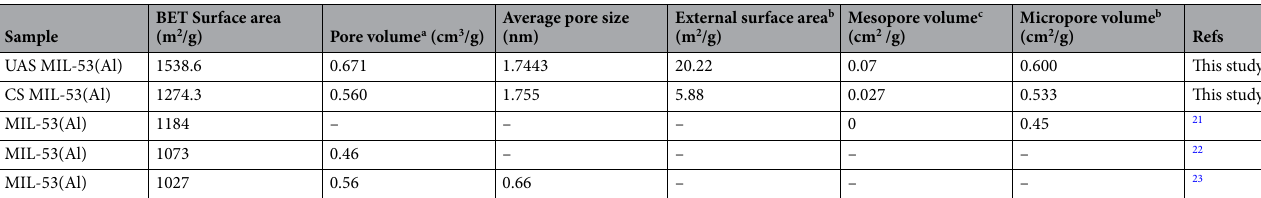
Table 1. Textural properties of different MIL-53(Al). a Measured using t-plot method. b Measured using t-plot